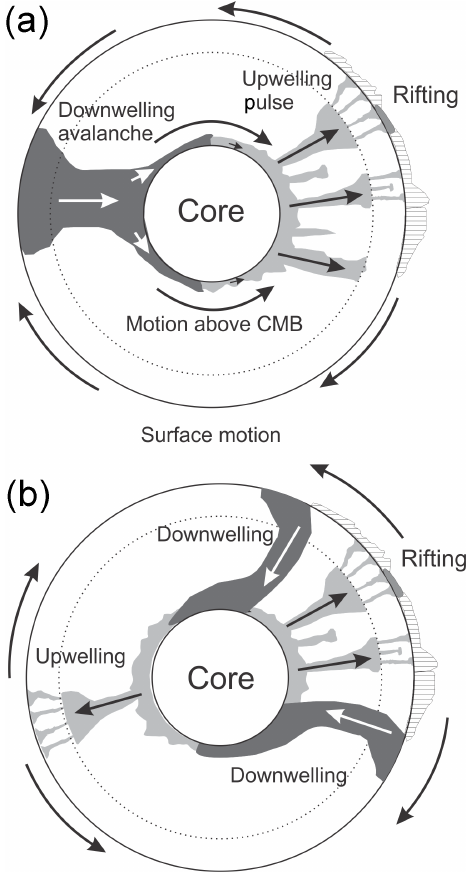
Figure 5. Conceptual sketch of the proposed mechanism of break- up. (a) Interpretation from Cases 1 and 2. (b) A further possible configuration of large-scale return flow involving continent fringing subduction zones (after Zhong et al., 2007). Not to